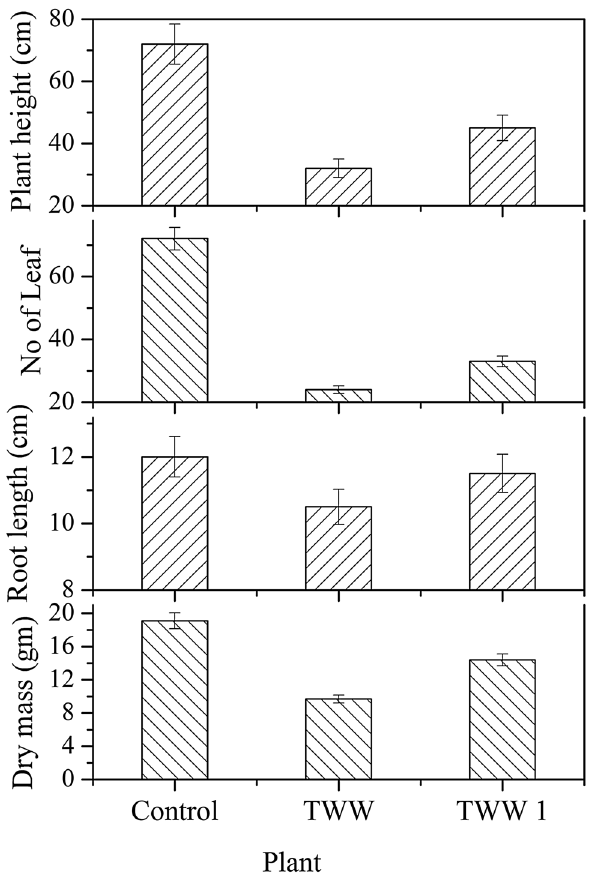
Fig. 9 Morphological properties of Malabar spinach after irrigation with water (control), wastewater (TWW) and catalyst-induced irradi- ated wastewater